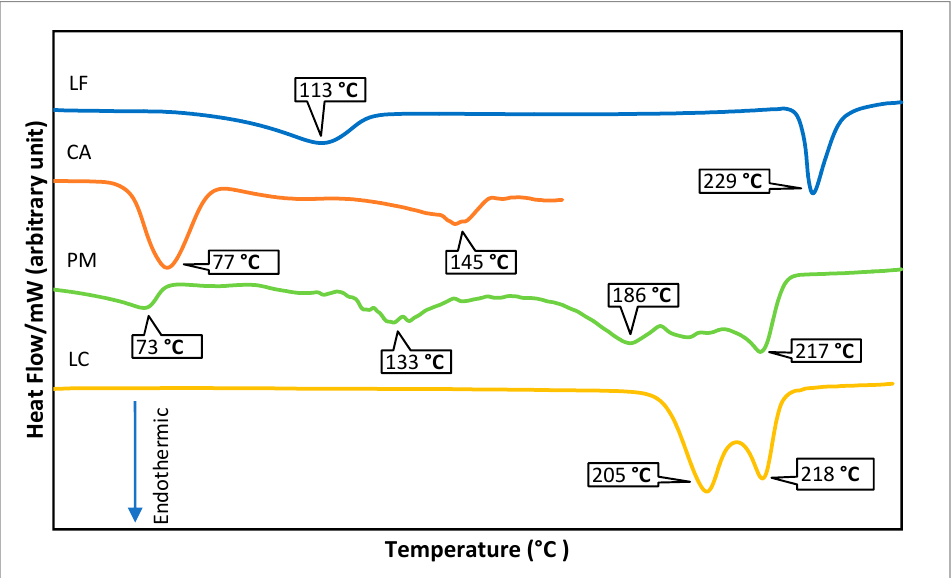
Figure 3. DSC thermogram of LC (1:1) compared to the starting materials, levofloxacin (hemihydrate), citric acid (dihydrate), and their physical mixture (PM).